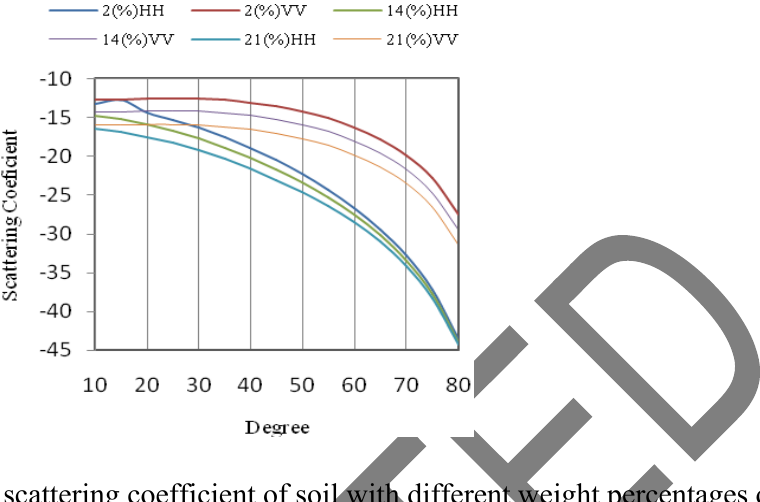
Figure 3. Variation of the scattering coefficient of soil with different weight percentages of diesel (3, 13 and 20) in respect to different look angles.